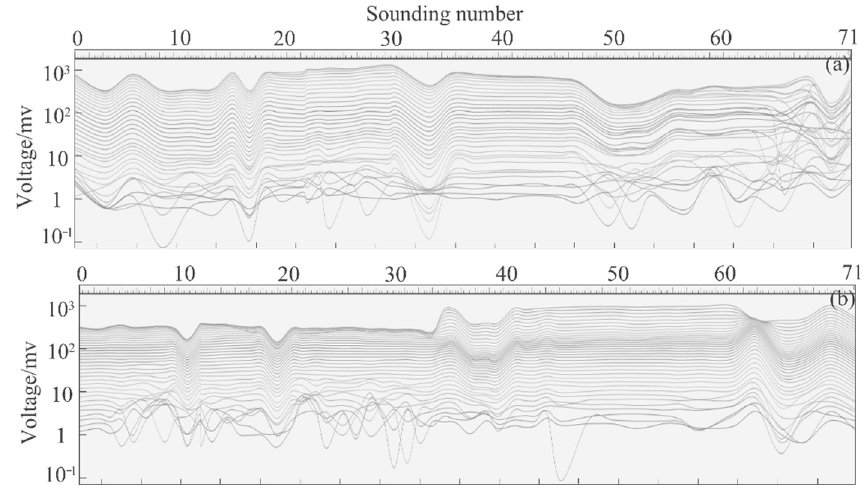
Figure 5. Layout of the transmitting source and survey lines.